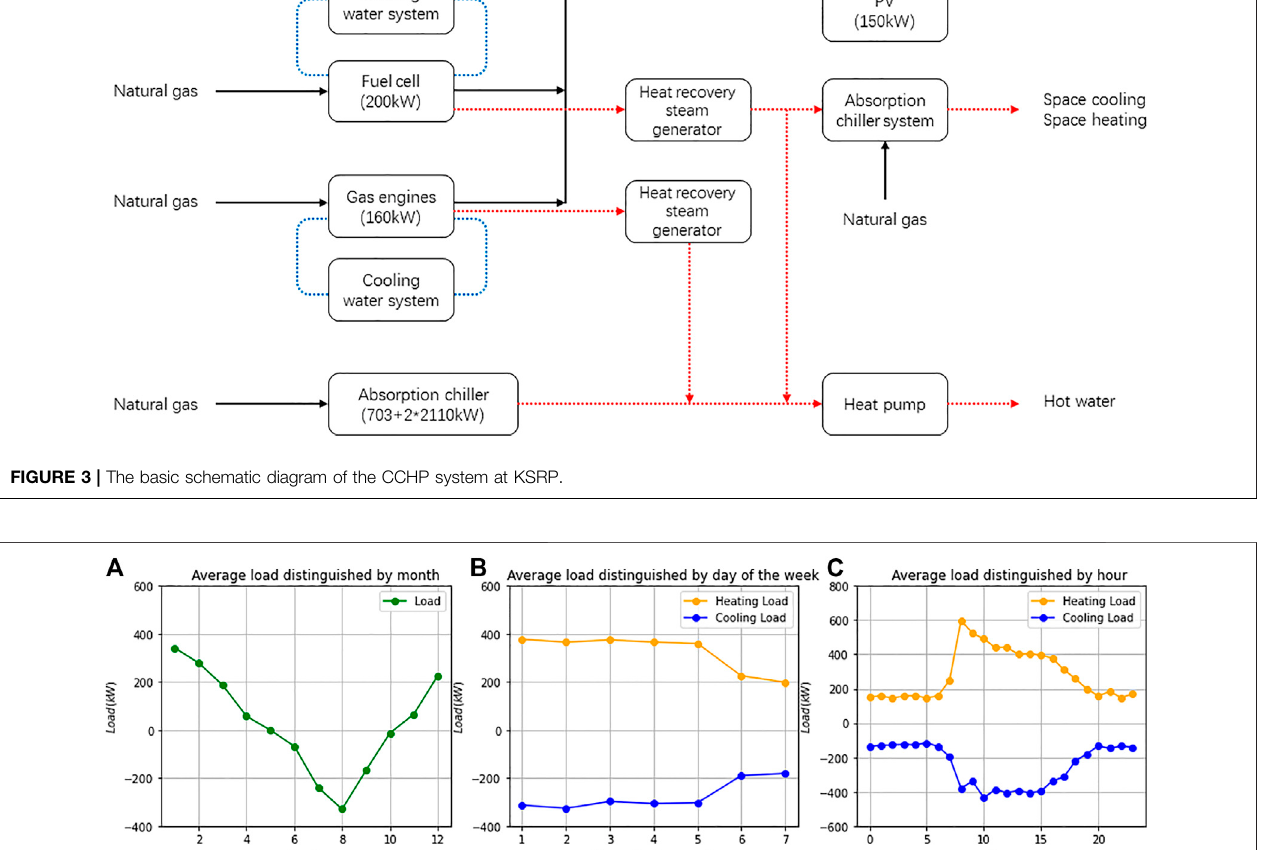
Frontiers in Energy Research |